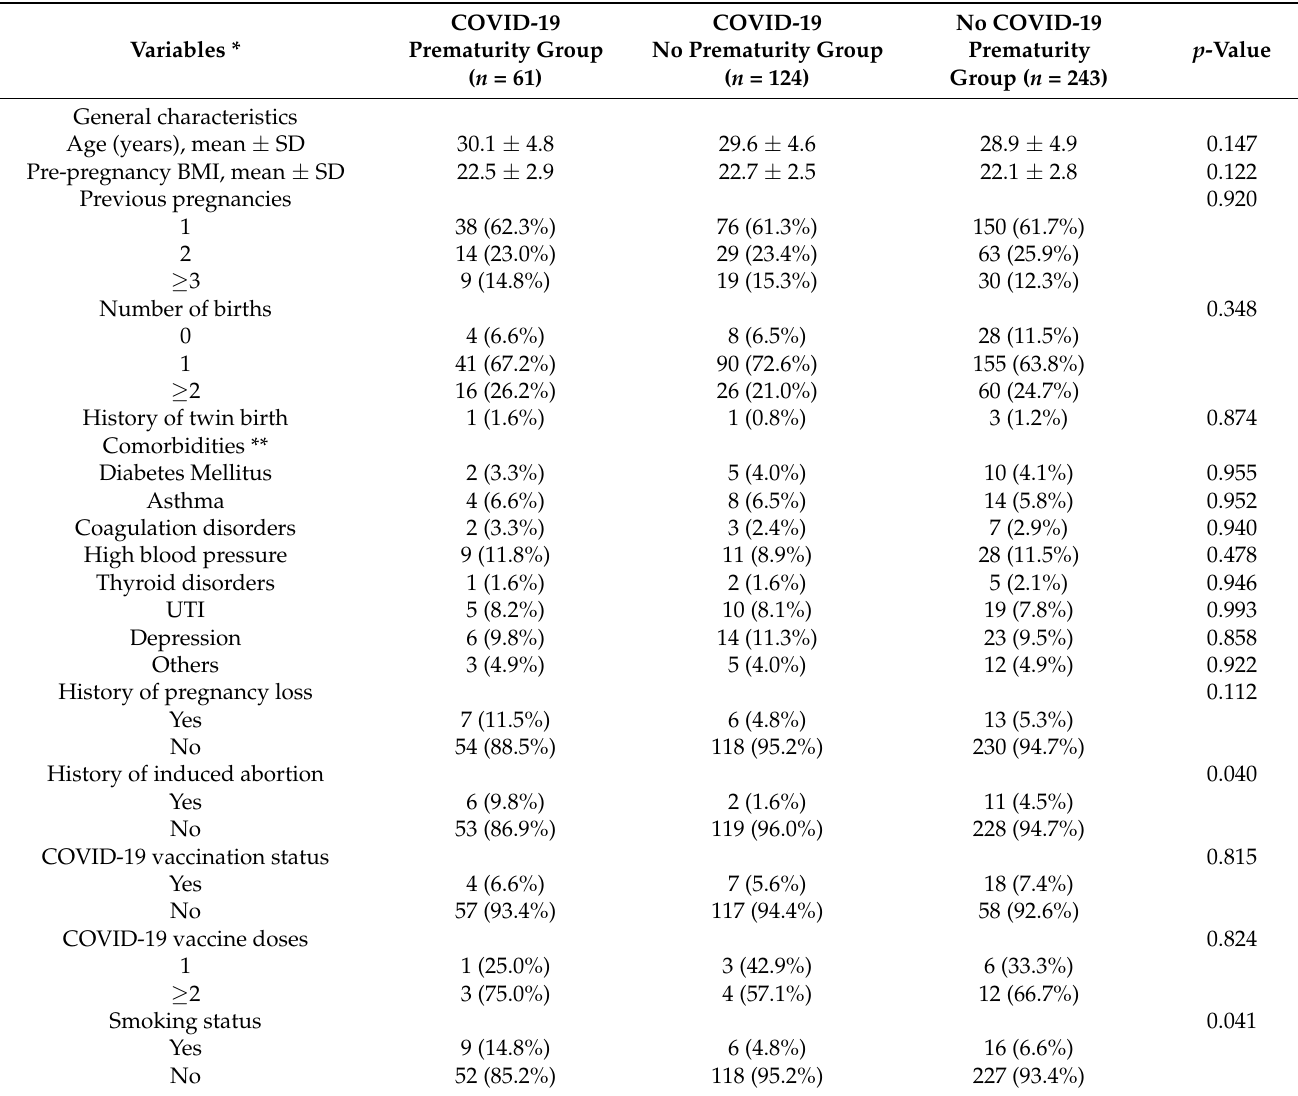
Table 1. Demographics of pregnant women included in the